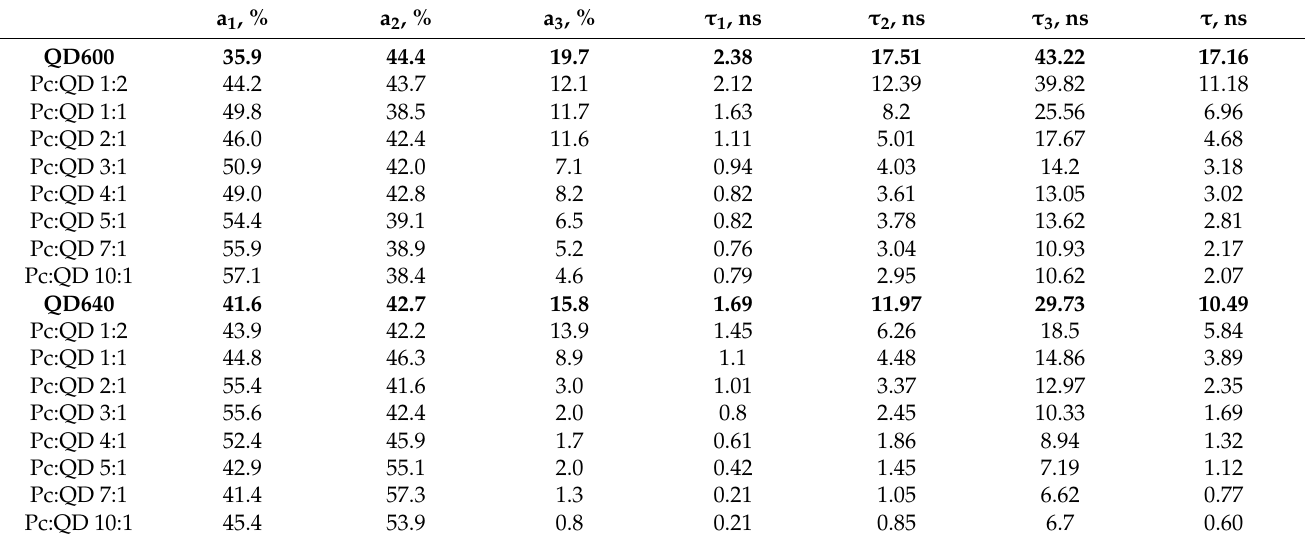
Figure A5. Fluorescence decay curves of AlPc8 ( left ) and ZnPc8 ( right ) in a solution without QDs and in conjugates with QDs with different Pc:QD stoichiometry. Fluorescence excitation wavelength is 675 nm, fluorescence detection wavelength is 710 nm. Table A1. Decomposition parameters of the QD fluorescence decay curves in a solution without Pc and in a conjugates with AlPc8 with different Pc:QD stoichiometry. The average fluorescence lifetime was calculated using the formula τ = ∑ 𝑎 (cid:3036) τ (cid:3036)(cid:3036) , where τ (cid:3036) and 𝑎 (cid:3036) are the time components and their contributions, respectively.